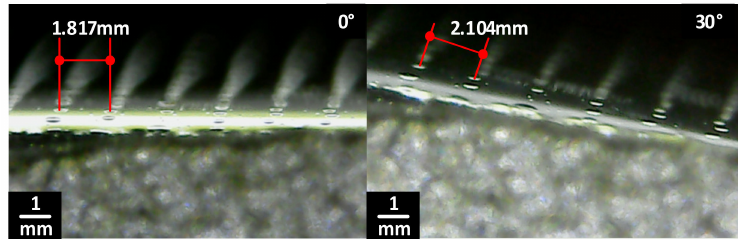
Figure 6. The separation distance between the droplets is expanded by 0.287 mm given that the substrate is tilted by 30 ◦